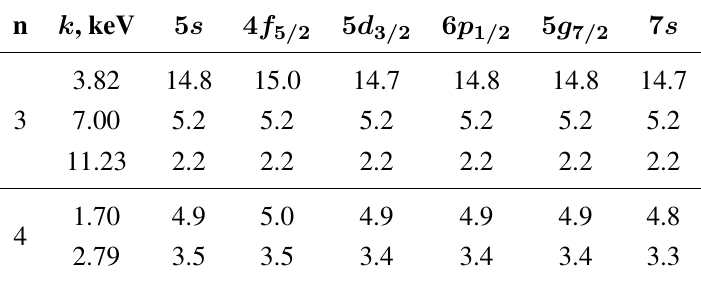
Figure 9. The electron density G 2 ( r ) + F 2 ( r ) in the range [0 − r 4 d (blue) shells of the ion W 28+ . Vertical lines denote values of r 3 / 2 4 d (blue) shells. 3 / 2 Table 4. The percentage enhancement factor ( F electron captured in various